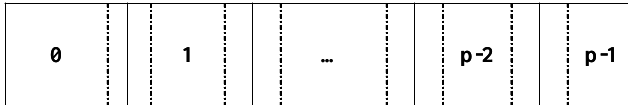
Figure 2. 1D block data